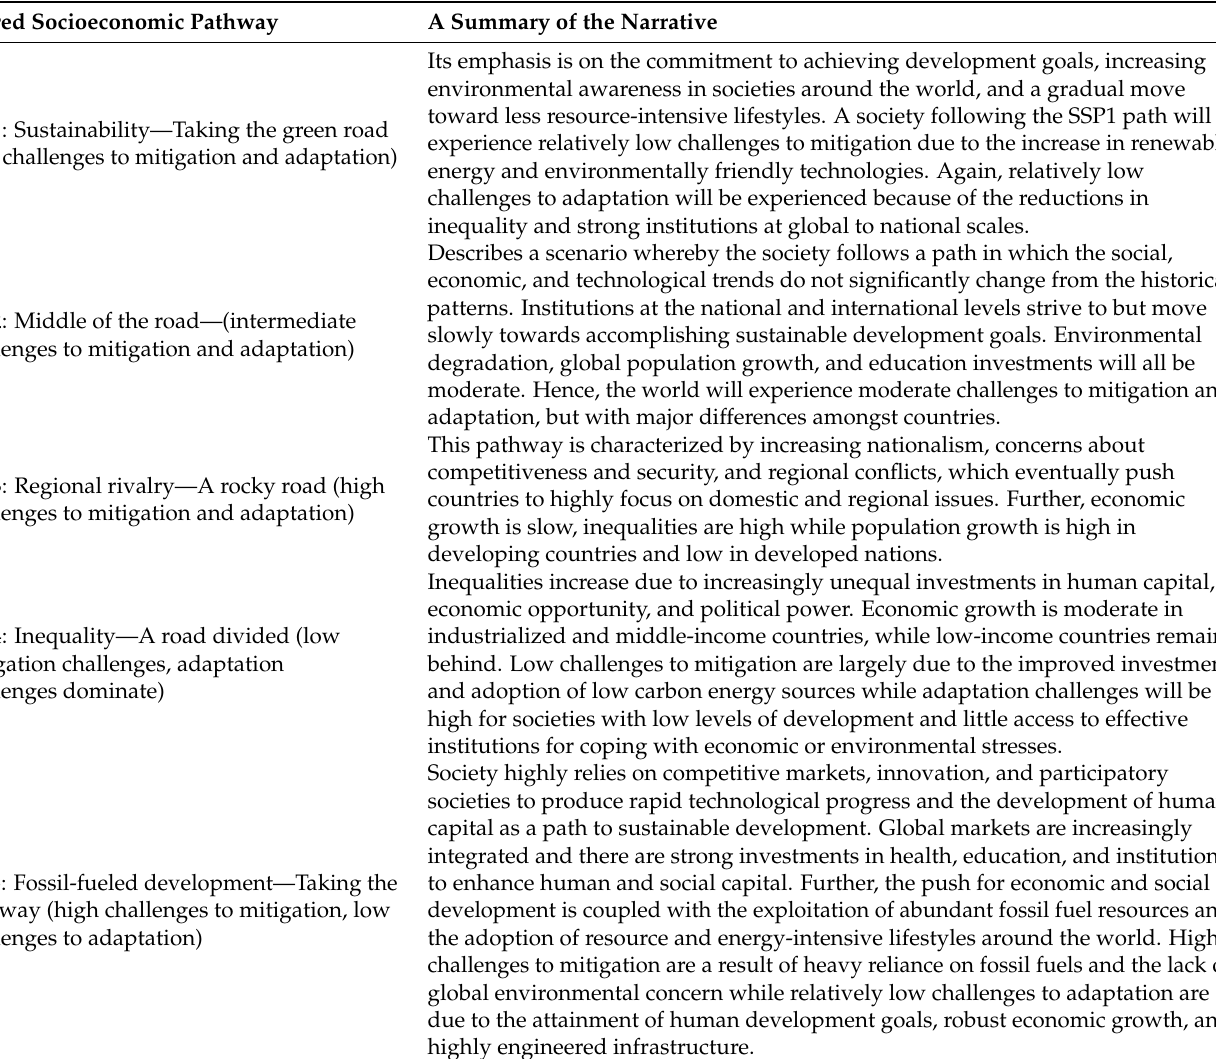
Table 1. A synopsis of the SSP and their narratives. Adapted from [130]. Shared Socioeconomic